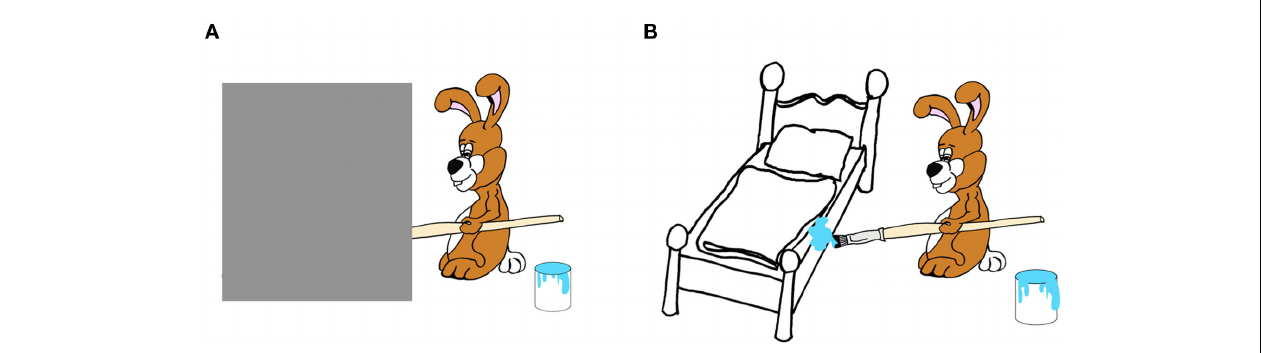
FIGURE 2 | Example trial of initial topic and final focus. (A) Experimenter: “Look! A rabbit (shown picture of a rabbit holding a brush). It looks like the